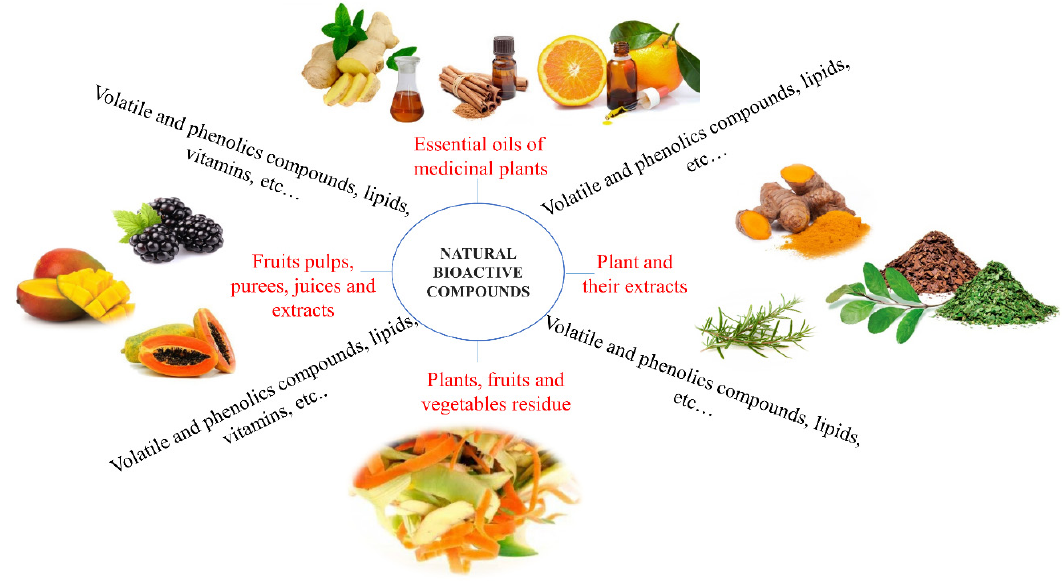
Figure 2. Examples of plant-derived bioactive compounds.